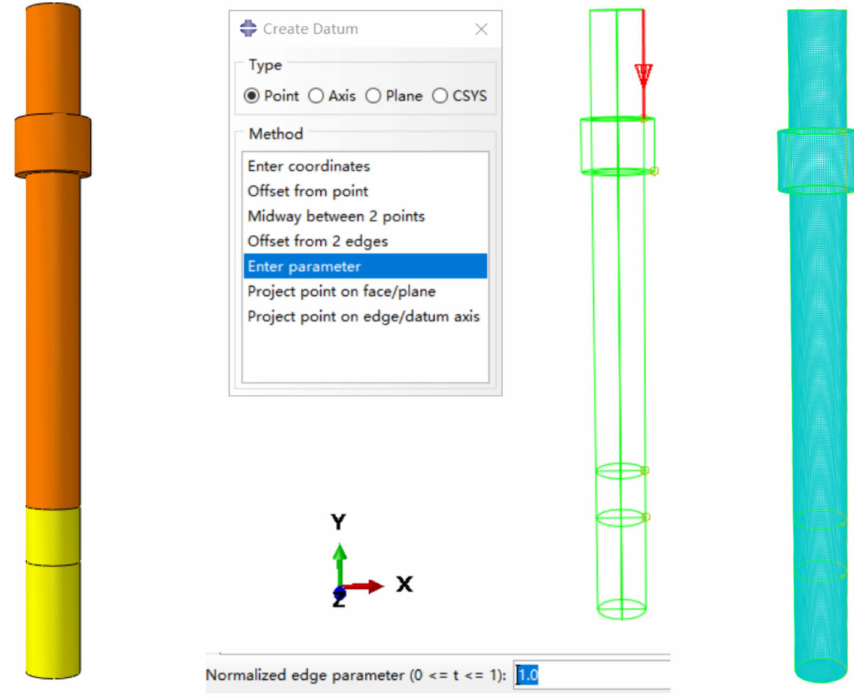
Figure 5. The process of adaptive mesh